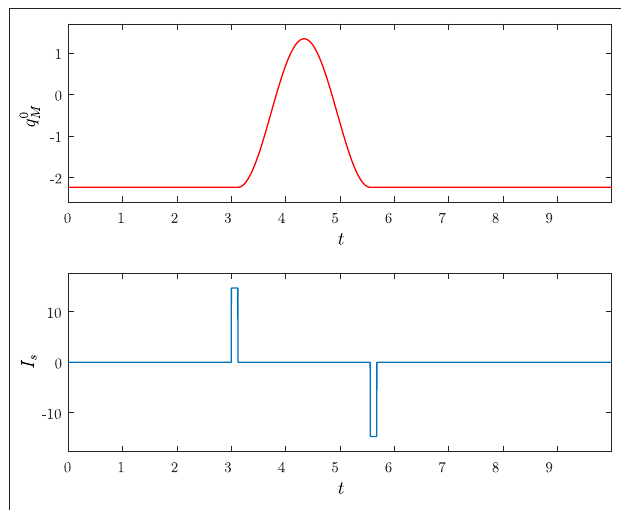
FIGURE 10 | Top : predicted behavior q 0 M ( t ) of the memristor charge. Bottom : timing of the current pulses.